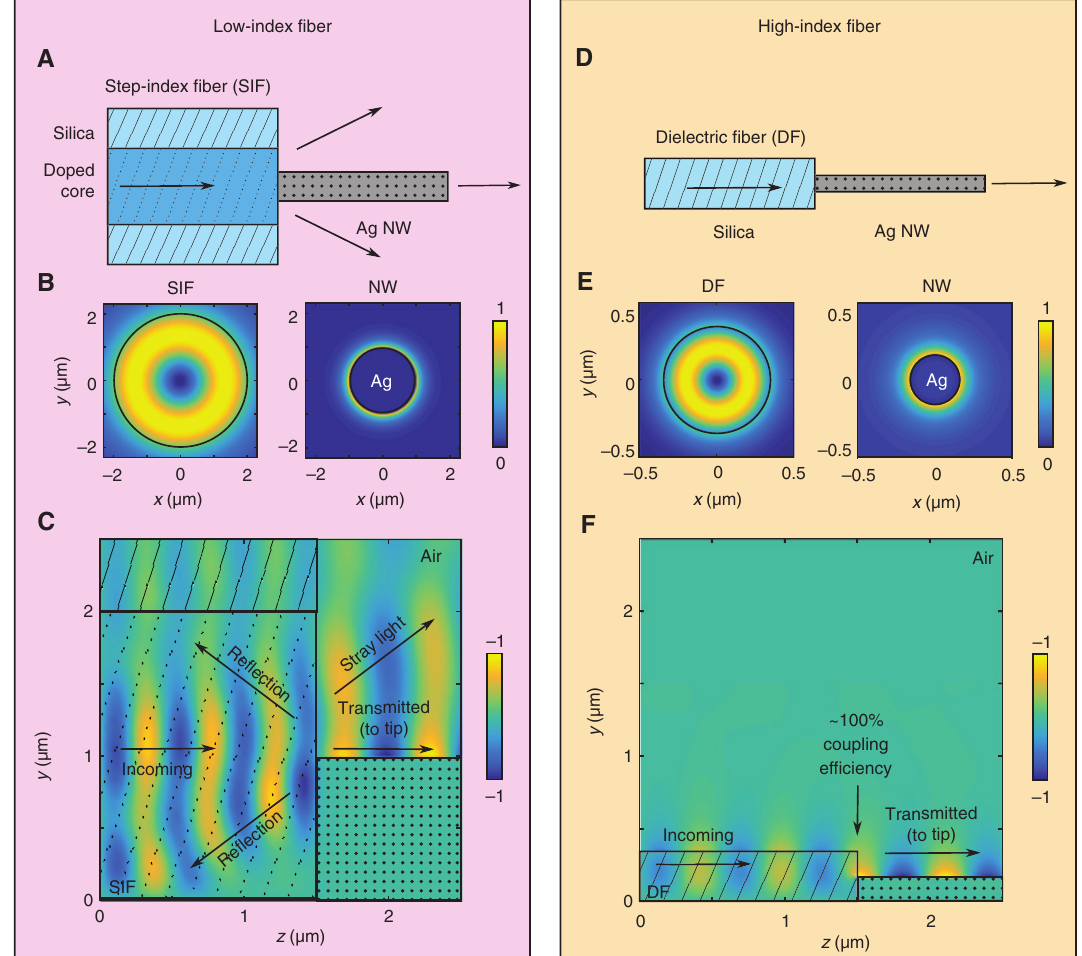
Figure 4: Schematics of typical structures that use end-fire coupling to excite the plasmonic modes. (A) State-of-the-art few-mode fiber (core radius: 2 μ m, index difference: 8 × 10 −3 ) that interfaces a plasmonic nanowire (radius: 1 μ m). (B) Calculated mode profiles for the RP modes of fiber (left) and SPP (right). (C) Propagation simulations, showing that the incoming field